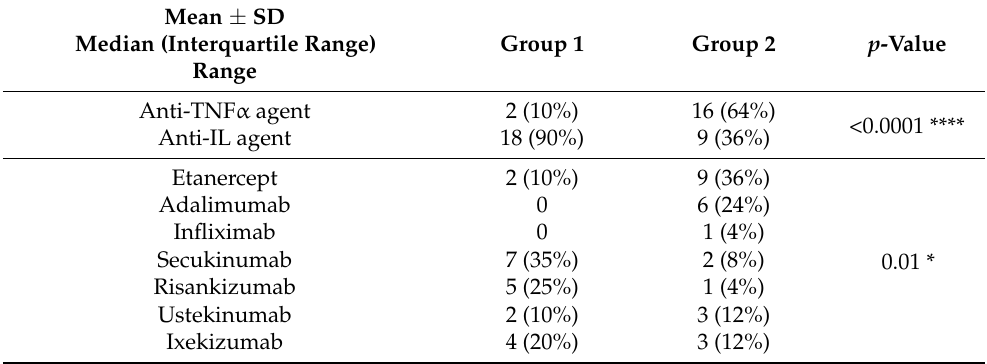
Table 2. Evolution of treatment in view of membership to one of the two